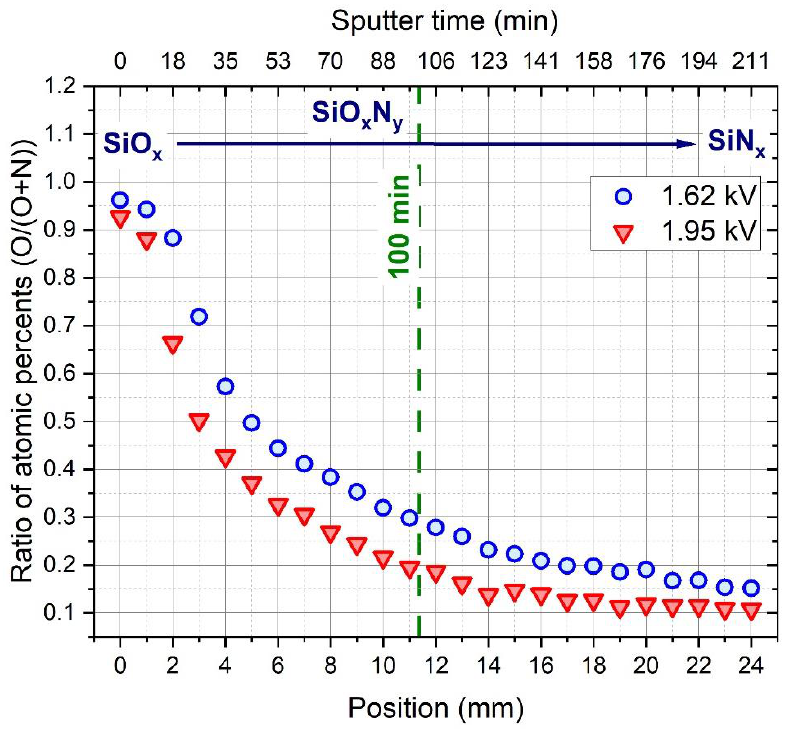
Figure 2. Ratio of atomic concentrations (O/O+N) determined by EDS measurements along the composition spread samples deposited at 1.62 and 1.95 kV DC potential.